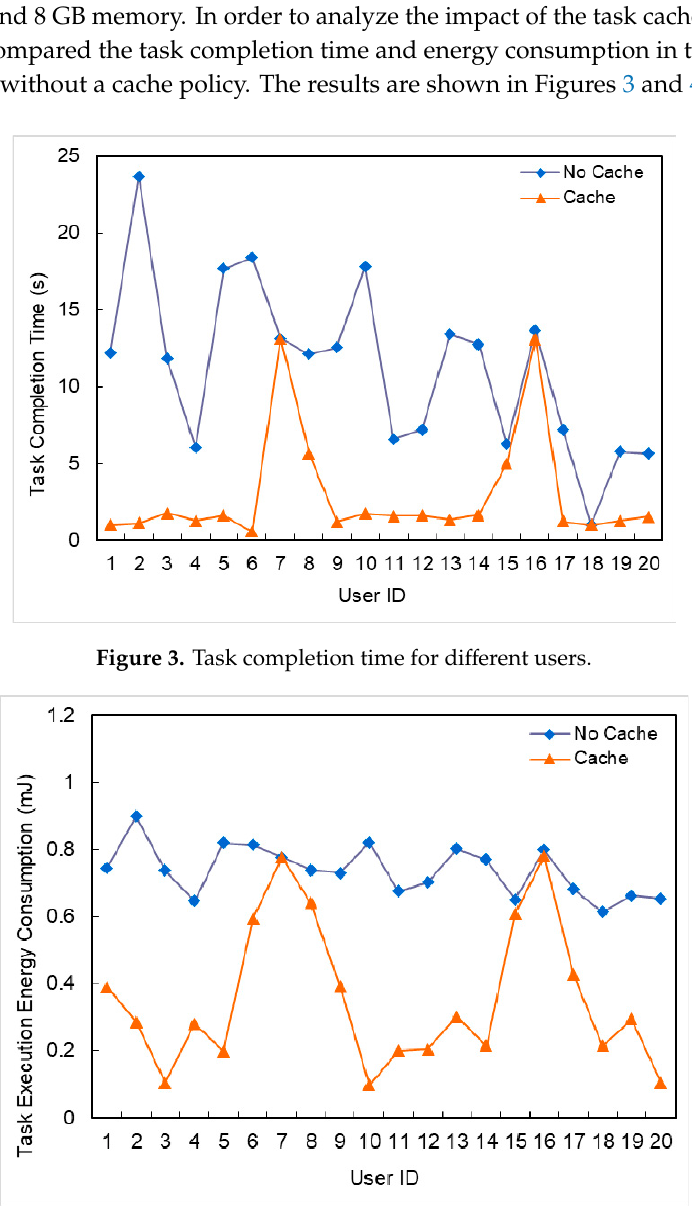
Figure 4. Energy consumption for different users.